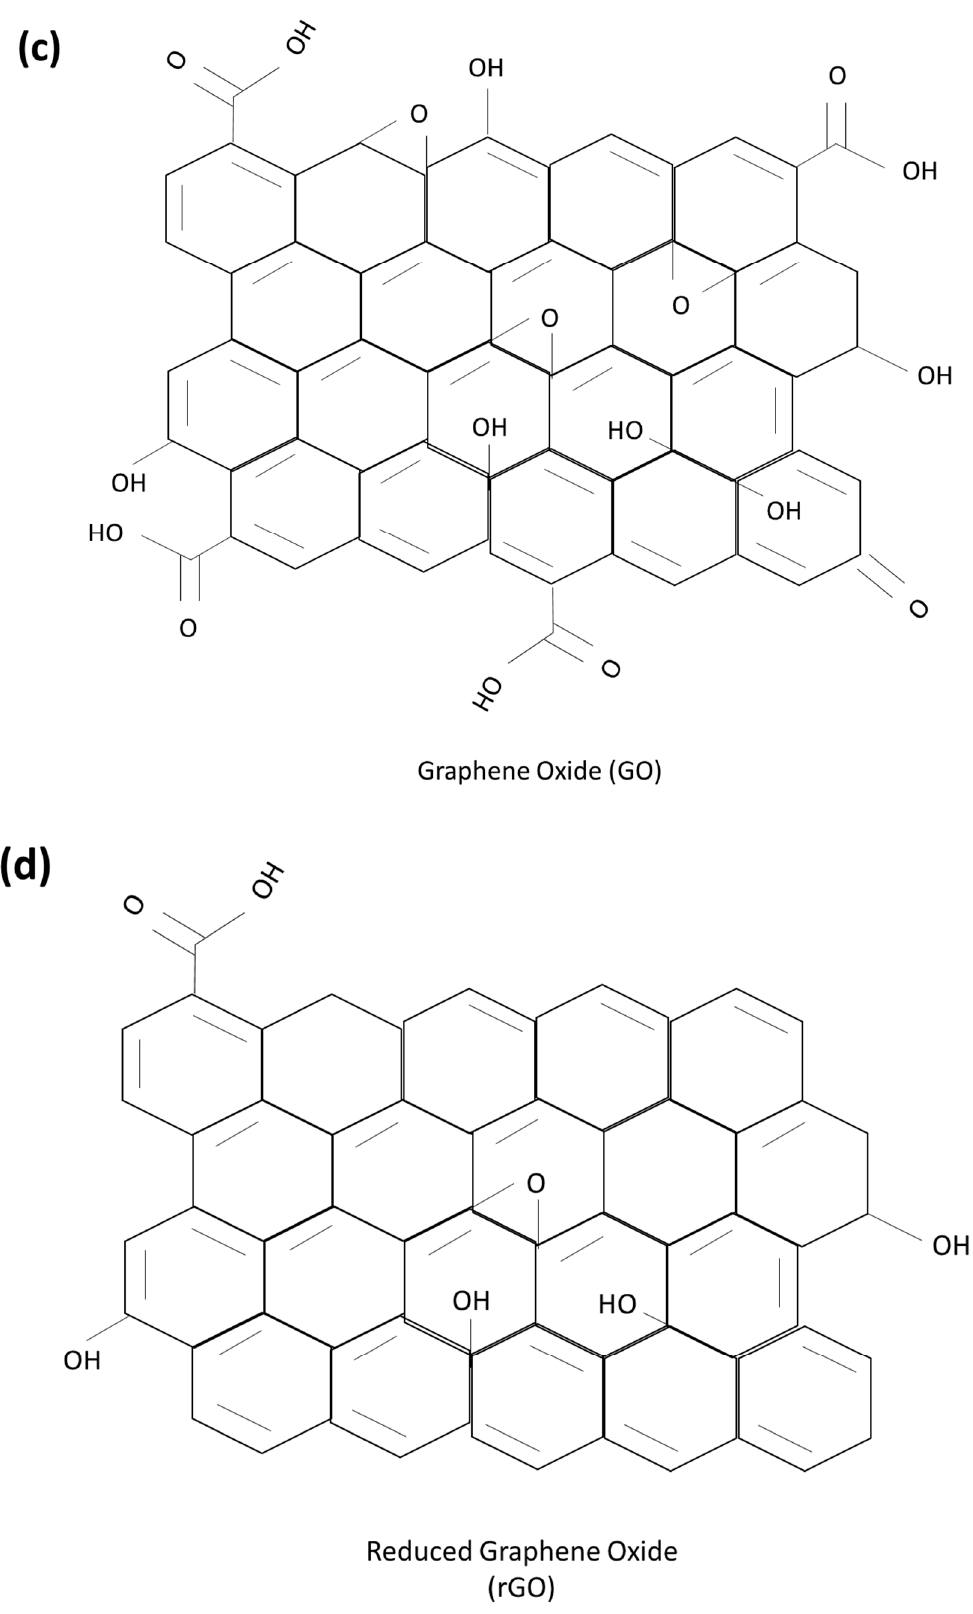
Figure 1. ( a ) Schematic diagram of GO and rGO synthesis, chemical structure of ( b ) graphite, ( c ) GO, and ( d ) rGO.